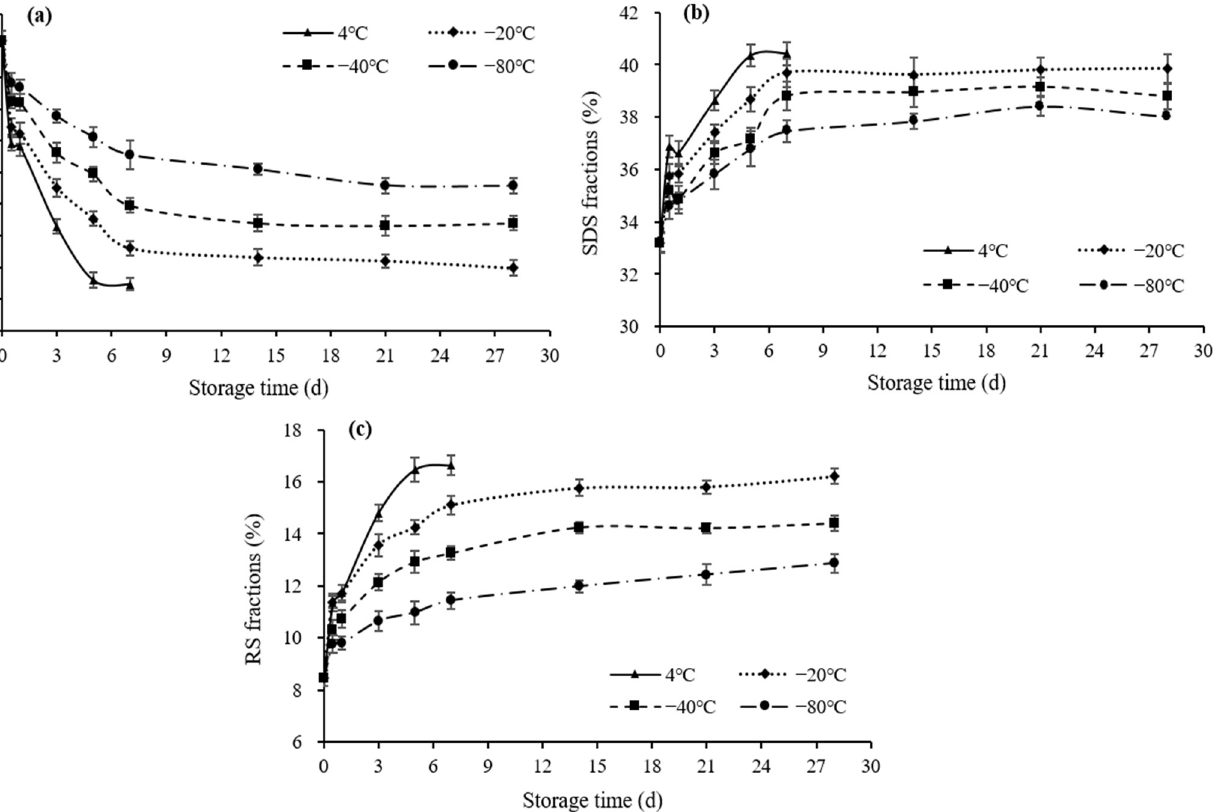
Figure 4. Starch fractions of cooked rice under different storage temperatures and periods. ( a ) RDS; ( b ) SDS; ( c ) RS. RDS, rapidly digested starch; SDS, slowly digested starch; RS, resistant starch. Error bars show the standard error of the mean ( n = 3).